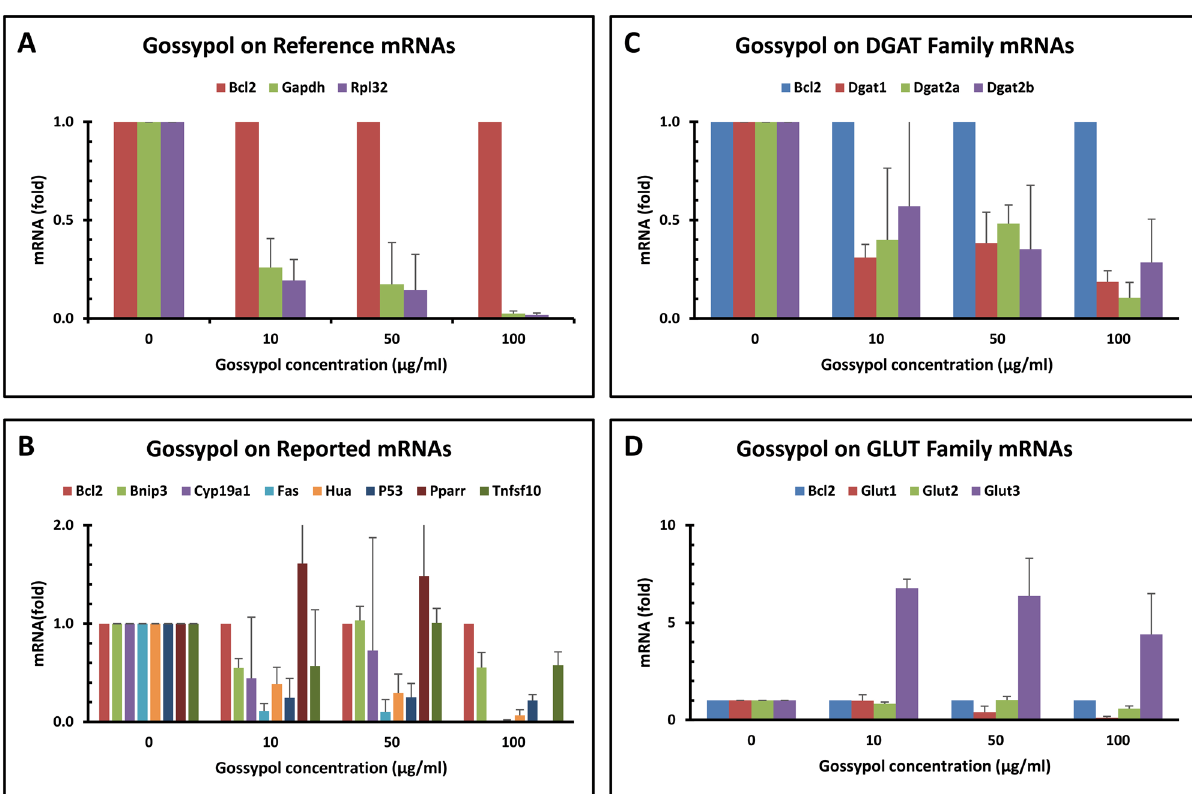
Figure 3. Gossypol regulated the expression of genes coded for qPCR reference mRNAs, genes reported to be regulated by gossypol, and genes coded for DGAT and GLUT mRNAs in human colon cancer cells. Human colon cancer cells (COLO 225) were treated with gossypol for 8 h. The data represent the mean and standard deviation of three independent samples. ( A ) genes coded for qPCR reference mRNAs, ( B ) genes reported to be regulated by gossypol, ( C ) genes coded for DGAT mRNAs, ( D ) genes coded for GLUT